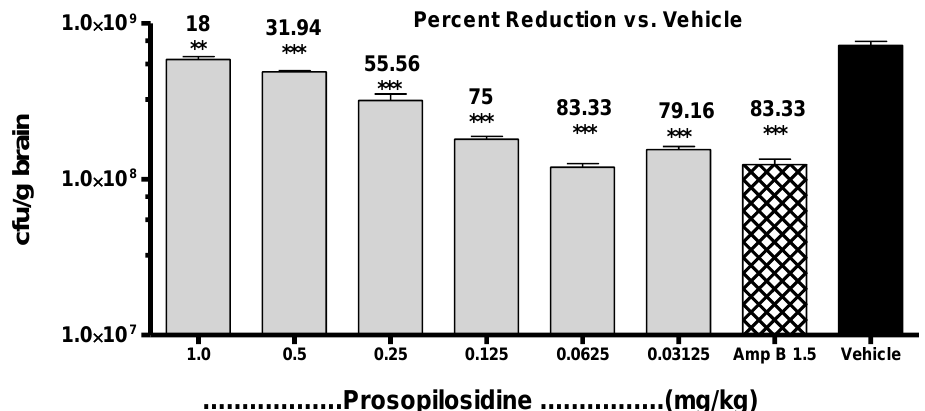
Figure 3. Treatment of Cryptococcus neoformans infection with different doses of prosopilosidine administered for 5 days in a murine model. Graph showing live colony forming units (CFU) of C. neoformans per gram of brain tissue with percent reduction in infection by prosopilosidine treatment given at doses 0.03125, 0.06215, 0.125, 0.25, 0.5, and 1.0 mg/kg body weight as compared to the vehicle control. Amp B: Amphotericin B (1.5 mg/kg body weight). Data are shown as mean + SEM ( n = 5) and was analyzed with ANOVA. ** p < 0.01, *** p < 0.001 is considered statistically significant compared to the vehicle control.